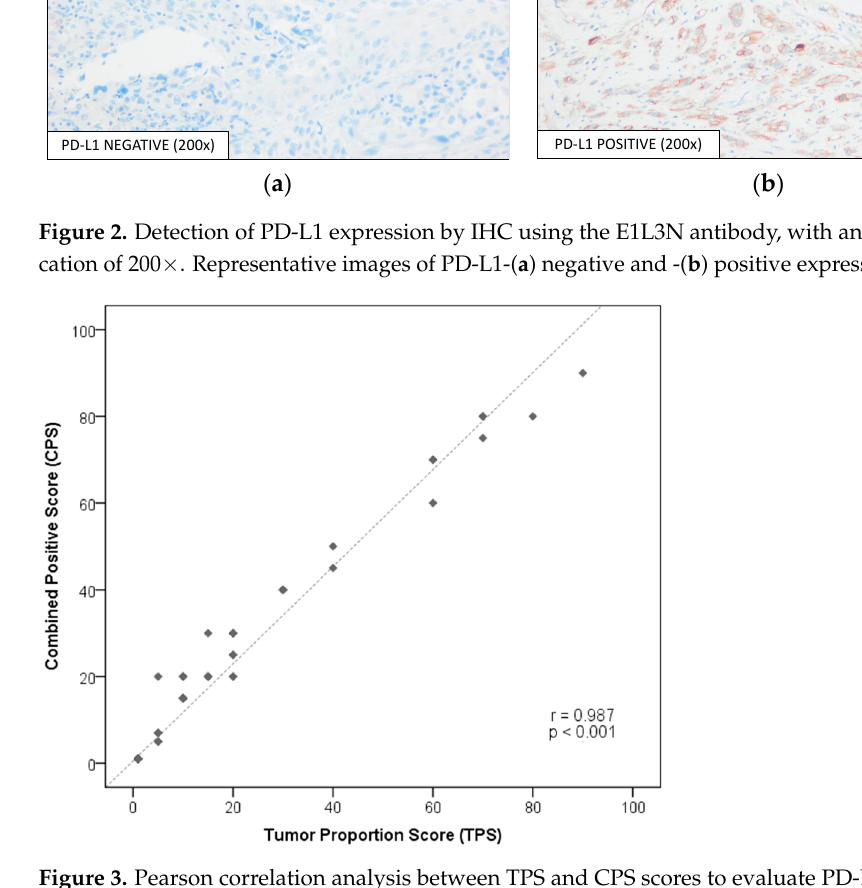
Figure 3. Pearson correlation analysis between TPS and CPS scores to evaluate PD-L1 expression in advanced melanoma patients’ samples.